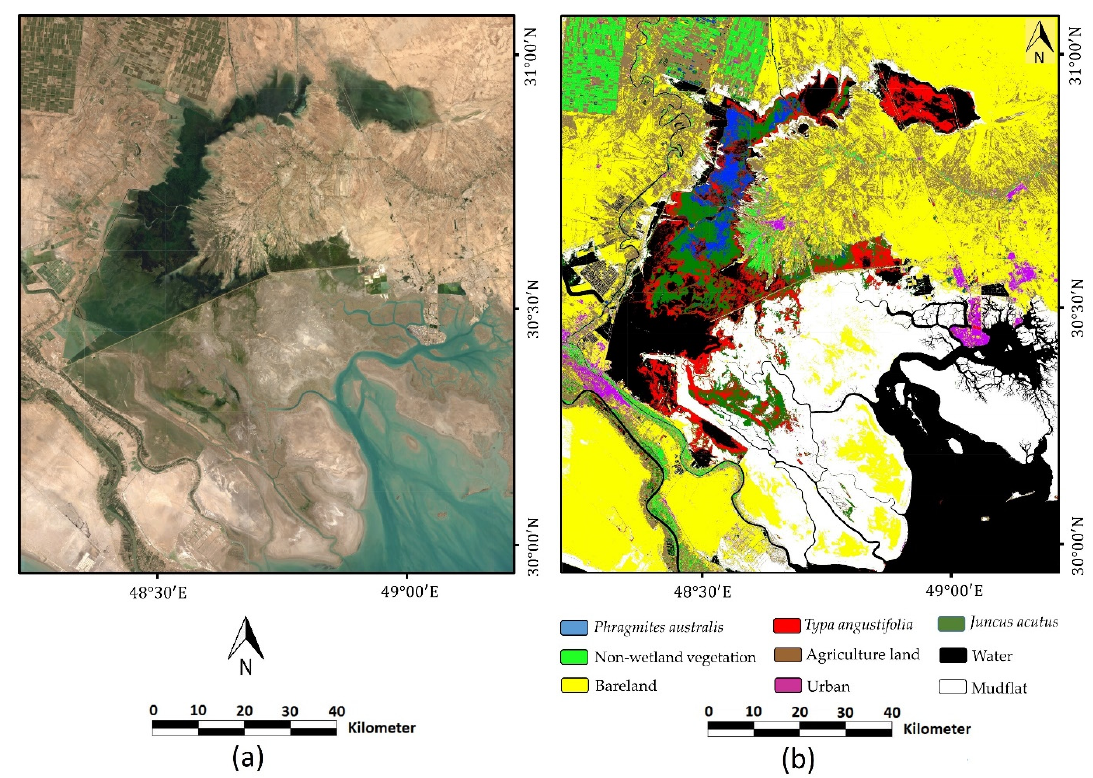
Figure A4. Growing season mosaic of the target year of 2019 ( a ) and wetland map of target year of 2019 using migrated samples ( b